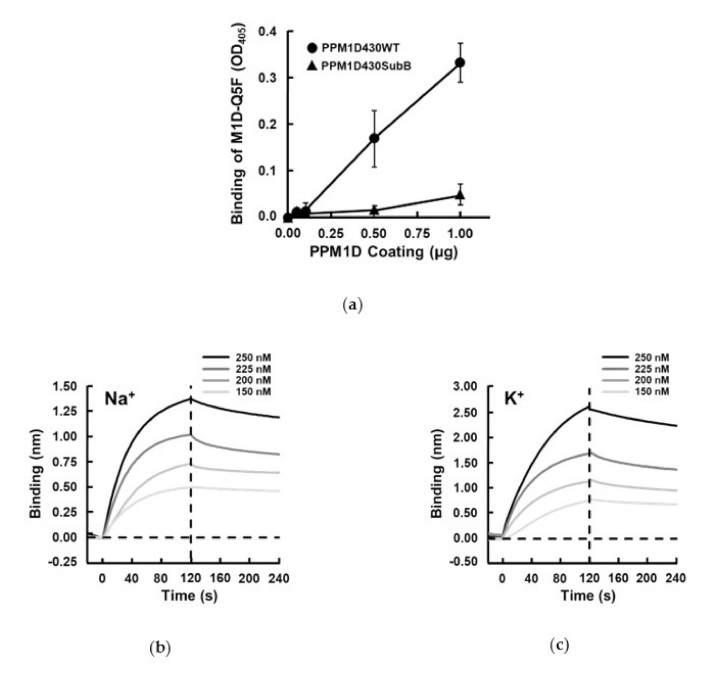
Figure 3. Analysis of binding properties of M1D-Q5F aptamer against PPM1D430. ( a ) ELISA